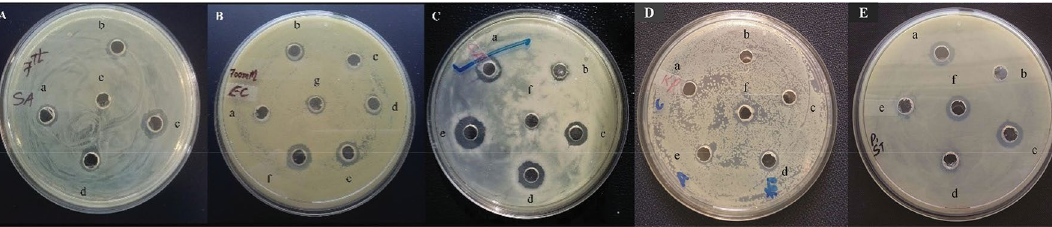
Figure 1. Cut-well agar diffusion showing antimicrobial activity against ( A ) Staphylococcus aureus ATCC 25923, ( B ) Escherichia coli ATCC 25922, ( C ) Candida albicans ATCC 10231, ( D ) Klebsiella pneumoniae ATCC 4352, and ( E ) Salmonella typhimurium ATCC 14028. a, b, c, d, e, and f indicated the cut-wells loaded at different steps of purification and